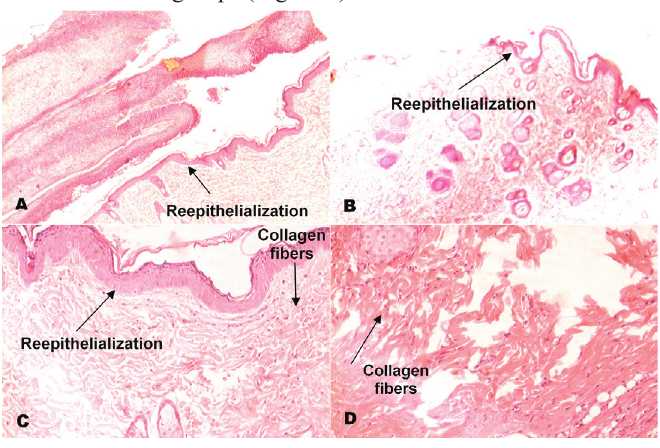
FIGuRE 2 – Reepithelialization and collagen fibers in the CG group ( A ); G2% group ( B ); G4% group ( C ); and G10% group ( d ). Hematoxylin and Eosin stain, magnification